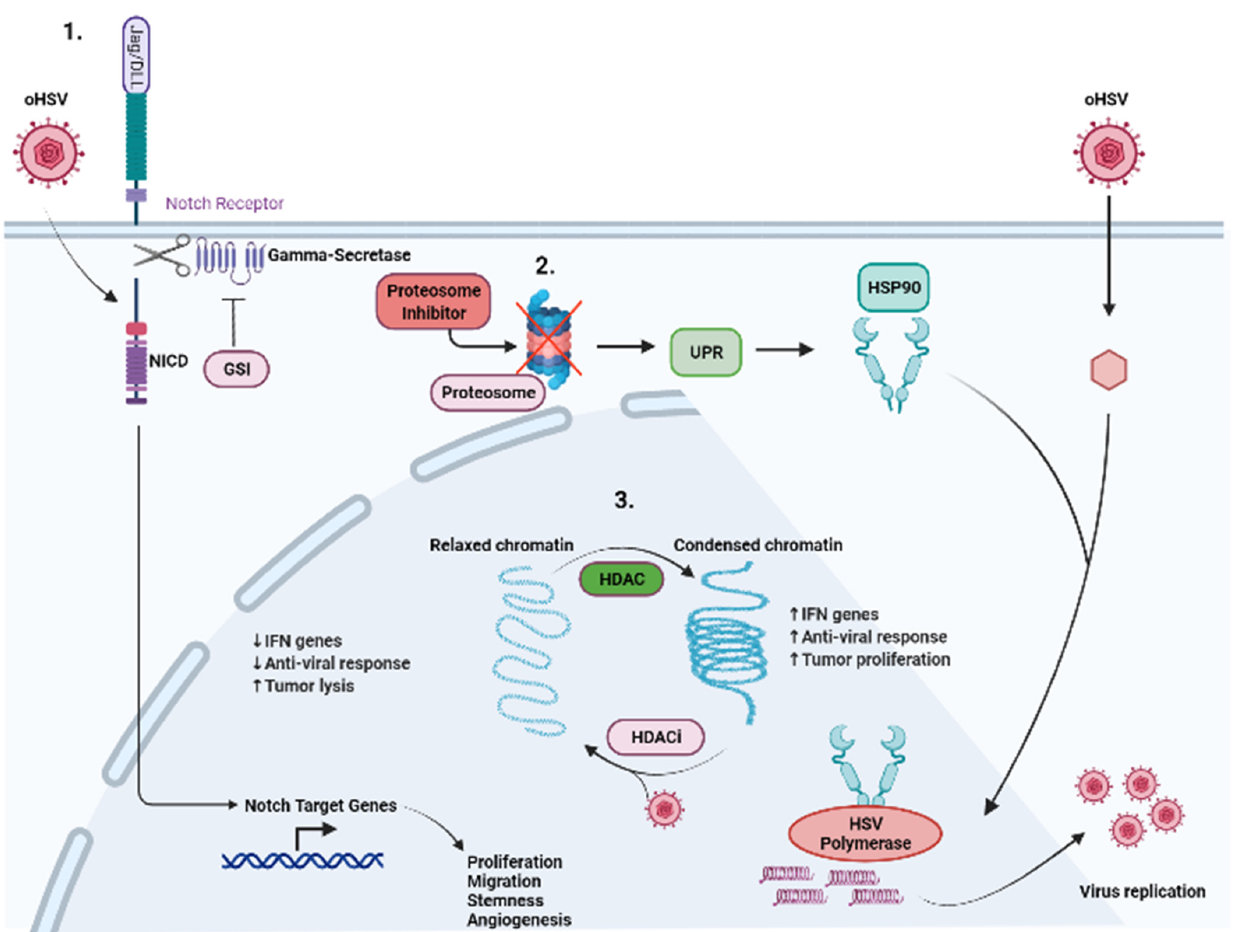
Figure 2. Modulation of cellular signaling to synergize with oHSV therapy. Multiple signaling pathways have been targeted in conjunction with oHSV therapy and highlighted are specific pathways which have been investigated. (1) Notch signaling highlights where Notch ligands from adjacent infected cells are binding to Notch receptors on uninfected cells. Binding of the Notch ligand causes a “pull” on the receptor, exposing the cleavage site on Notch-ICD (NICD). Gamma-secretase cleaves the NICD which subsequently leads to the expression of Notch target genes, leading to the